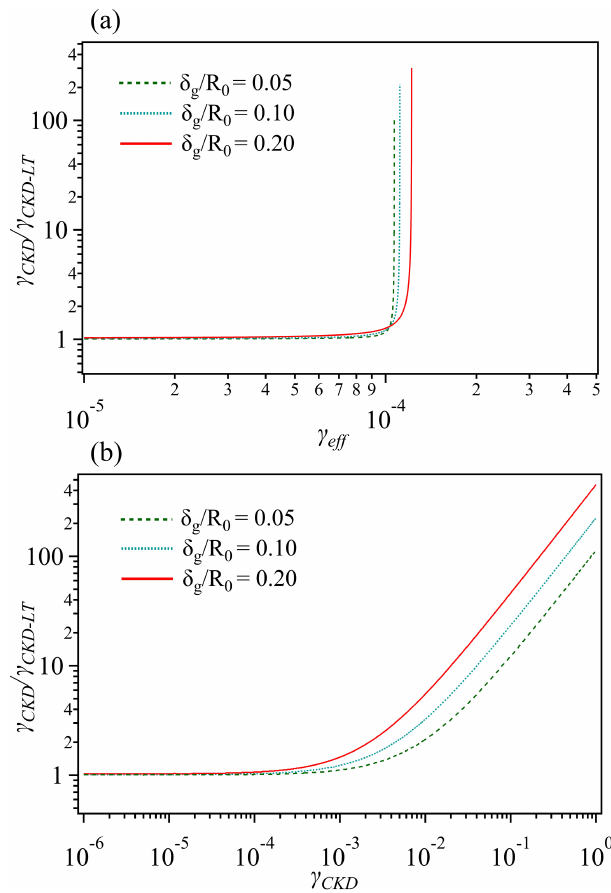
Figure B1. Maximum error of the CKD derived uptake coeffi- cient ( γ CKD ) relative to the CKD-LT derived uptake coefficient ( γ CKD-LT ) versus changing γ eff (a) and γ CKD (b) for three cases with different ratio of the geometric coating thickness to tube ra- dius ( δ g / R 0 ). For derivation of this plot, the specific experimental configuration includes gas reactant, O 3 ; carrier gas, N 2 ; volumetric flow rate F = 1Lmin − 1 at 1atm and 298K; flow tube dimension, d = 7mm, L = 250mm. The choices of δ g /R 0 cover the general ratio range in previous studies. The curves cannot be further ex- tended due to reaching the limits of diffusion correction methods (see Appendix